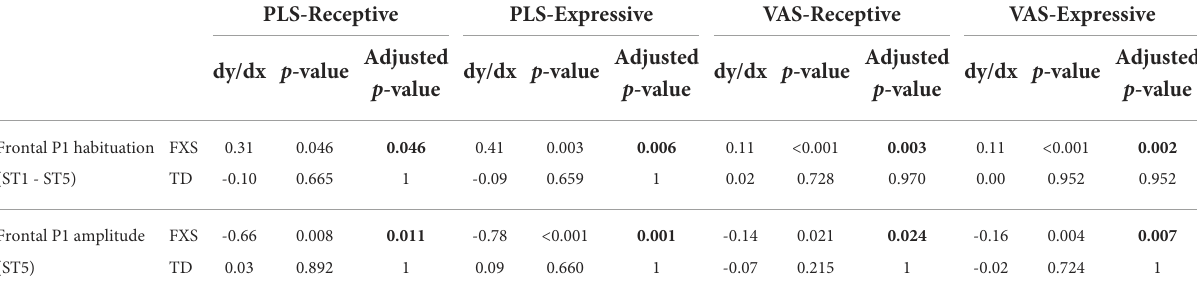
TABLE 4 Marginal effects in Model 1 for the association between EEG and language measures in each